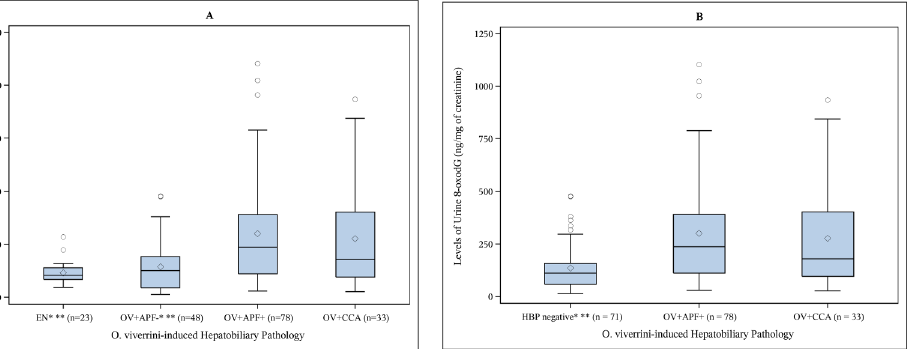
Fig 2. Levels of creatinine corrected urinary 8-oxodG are significantly elevated in O . viverrini infected individuals with advanced periductal fibrosis (APF) and O . viverrini induced intrahepatic cholangiocarcinoma (CCA). The distributions of 8-oxodG levels in urine are shown in Panel A for all four groups and in Panel B for three groups, with the first group in Panel B being a combination of Endemic Normal ( O . viverrini negative) and the APF- participants into a single hepatobiliary negative control group. The length of the boxes represents the interquartile range (IQR) or the distance between the 25th and 75th percentiles of each urinary 8-oxodG study group. The median value of each urinary 8-oxodG group are represented by the solid horizontal line in each box; the mean value of the group is depicted by the diamond character in the boxes. The bottom whisker represents the value of the lowest observation in the group. The highest observations in the group are represented by the uppermost circles above the group box; the upper whiskers represents the highest observations within 1.5x IQR. a Significant difference exists between this group and the APF+ individuals; this result was obtained using Dunn's procedure for multiple comparisons following the Kruskal-Wallis one way analysis of variance. b Significant difference exists between this group and the CCA individuals; this result was obtained using Dunn's procedure for multiple comparisons following the Kruskal-Wallis one way analysis of